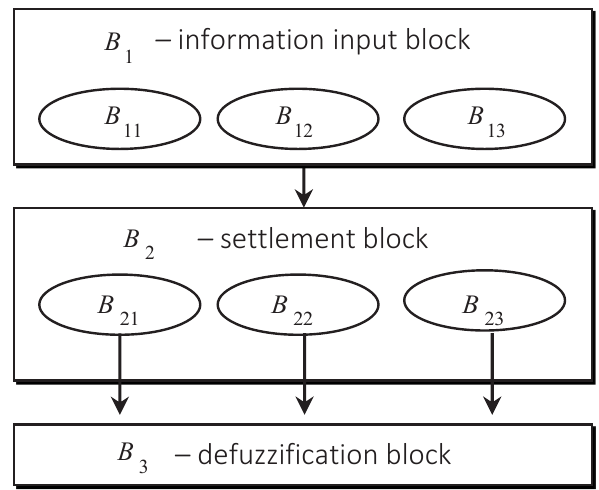
Figure 4. Main blocks of the framework of the developed methodological